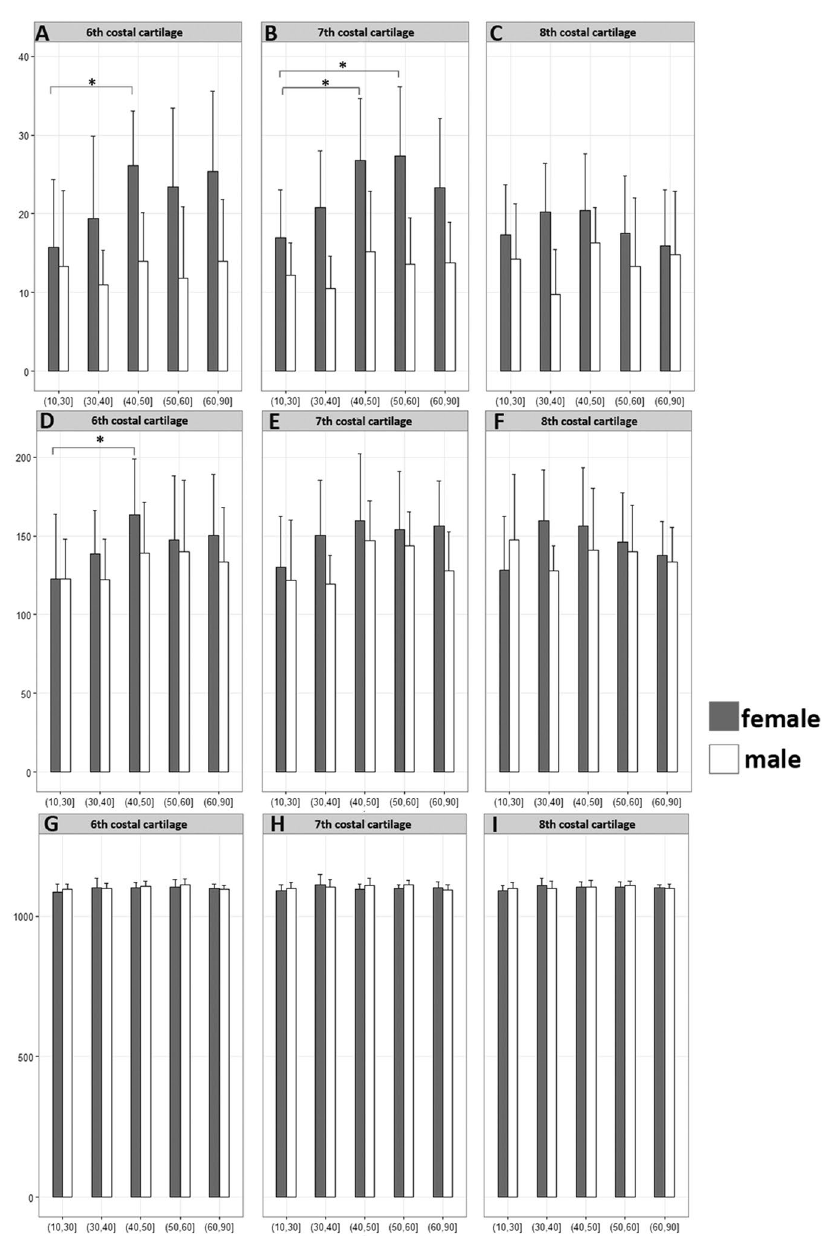
Figure 3. The measurement results of costal cartilage. ( A , B , C ) The calcium concentration of costal cartilage in different groups. A gradual increase of calcium concentration was found before 50 years old groups in female patients and a slight decrease after 50 years old. ( D , E , F ) The CT values of costal cartilages in different age groups. The CT values of costal cartilages went through a gradual rising before 50 years old in female patients, which were in accordance with the tendency of calcium concentration. ( G , H , I ) The water concentration of costal cartilage in different groups. The water concentration both in female and male patients was almost the same in all age groups. * P <